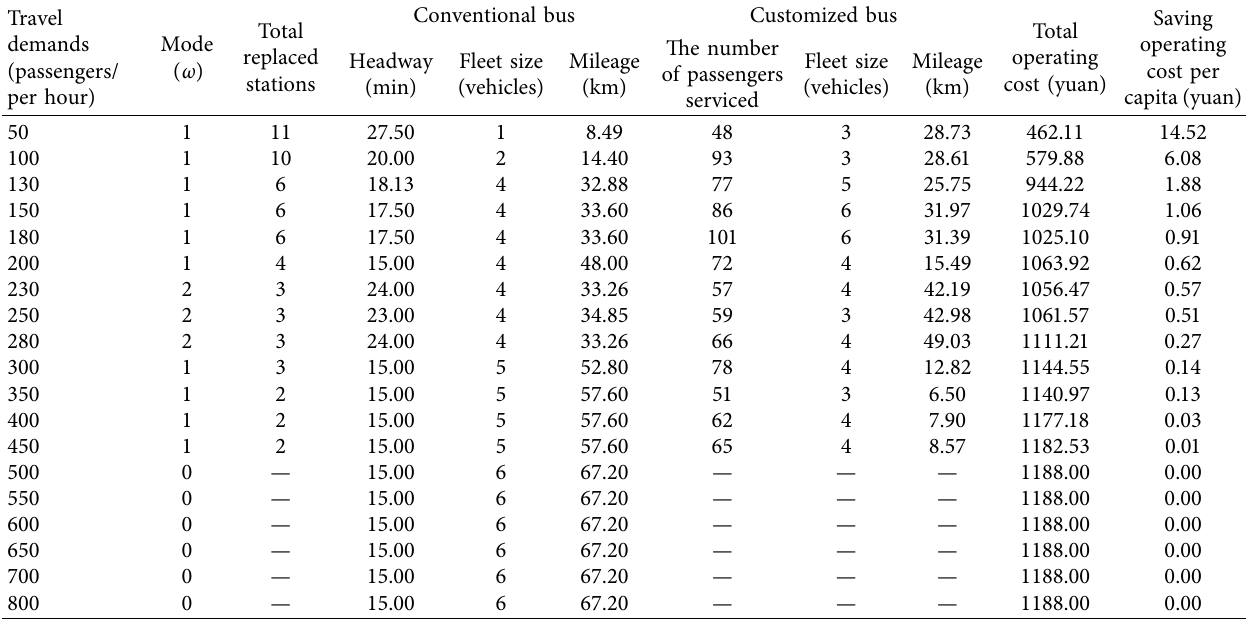
Table 5: The optimal bus operation plans with different travel demands in integrated operation mode I. Travel demands